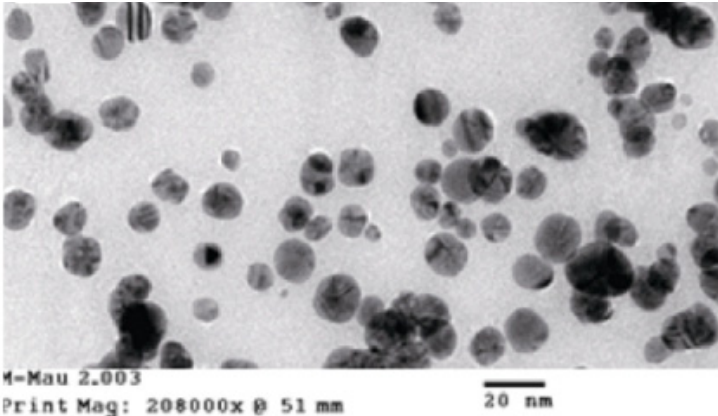
Figure 3. TEM image of silver nanoparticles [82].